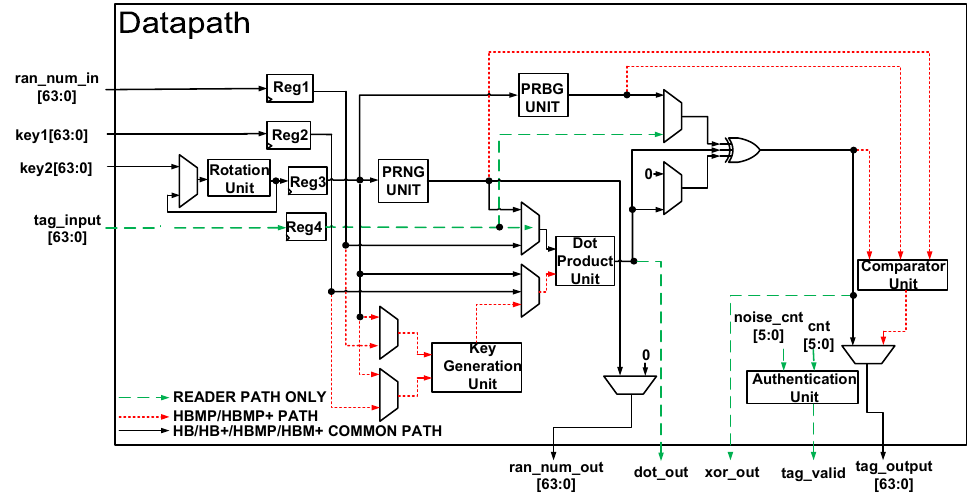
Figure 6. Proposed datapath for unifying the lightweight authentication protocols.